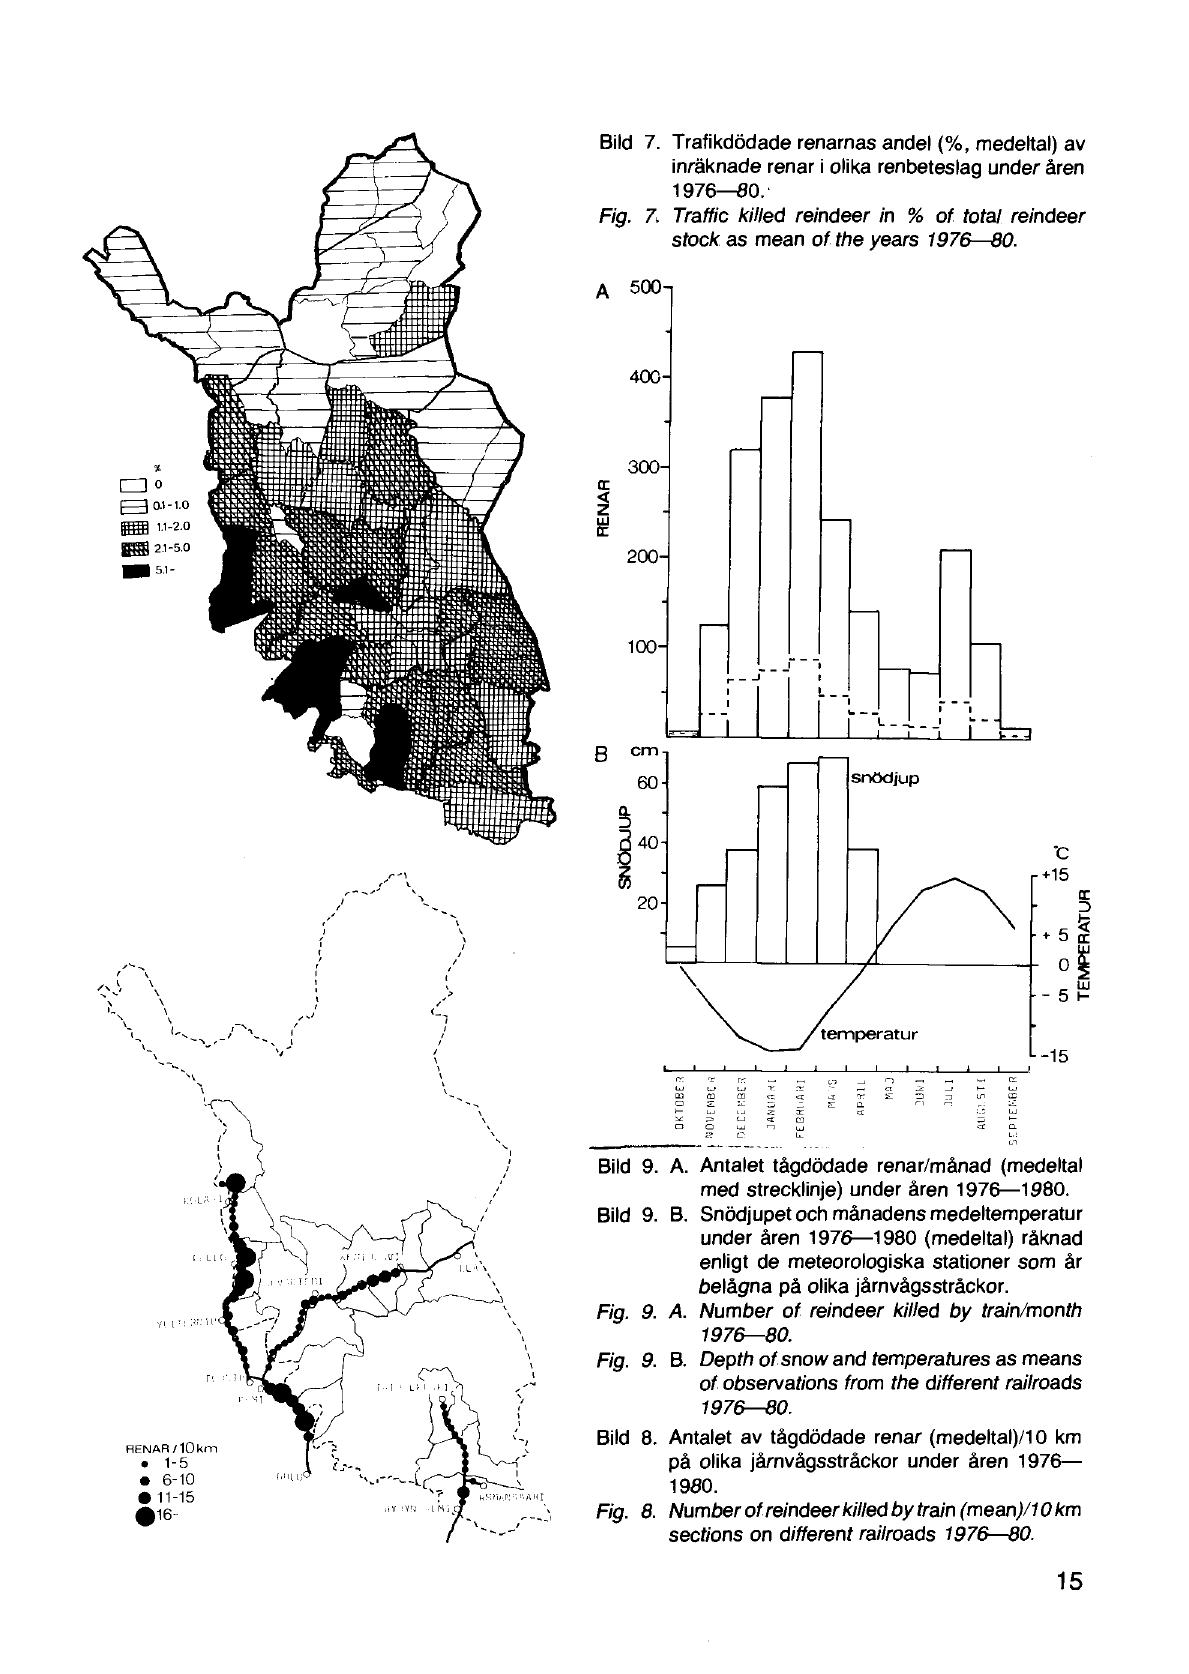
Fig. 8. Number of reindeer killed by train (mean)/10 km sections on different railroads